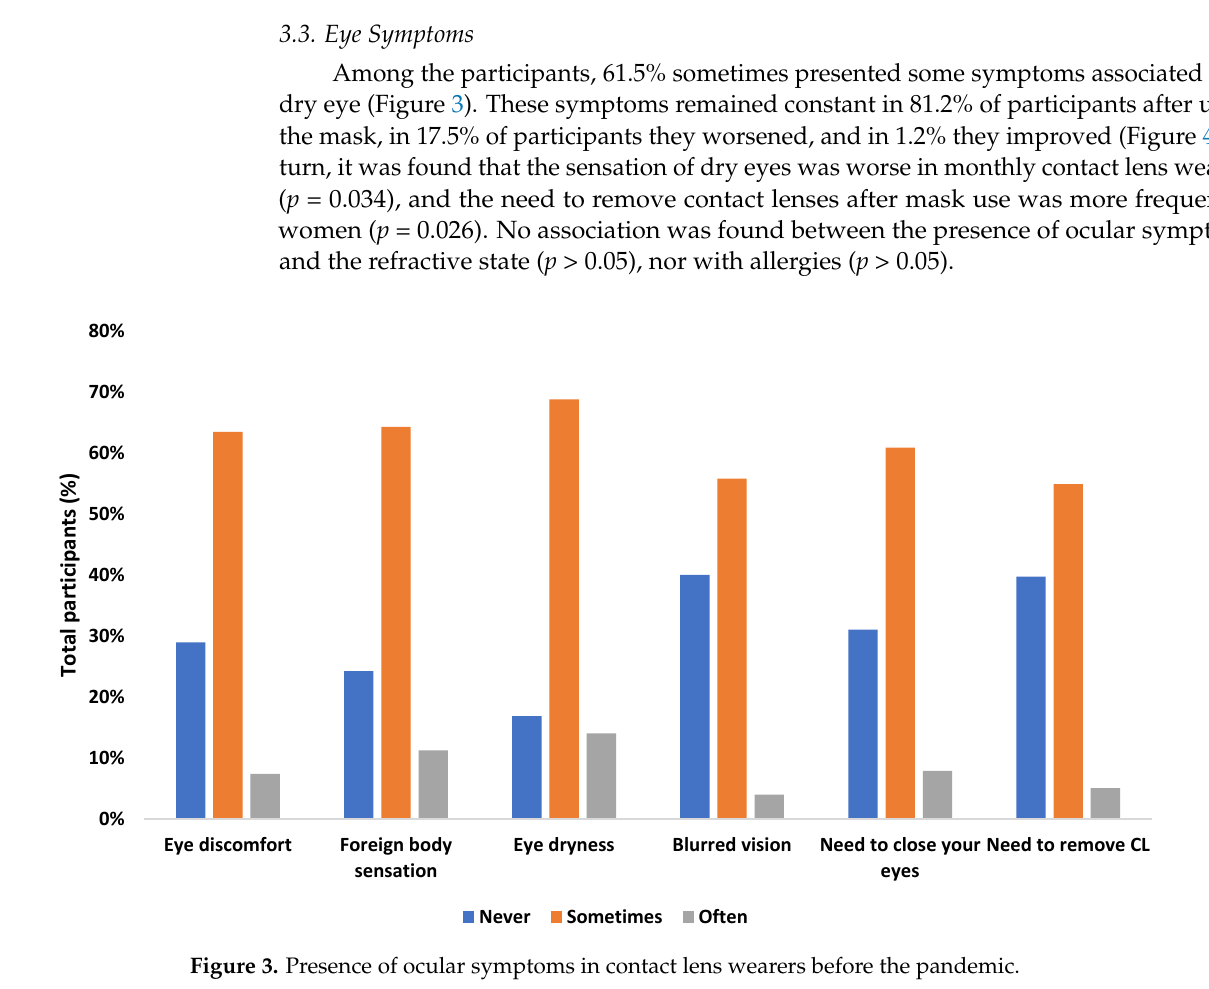
Figure 2. Hours of contact lens wear before and after the pandemic.